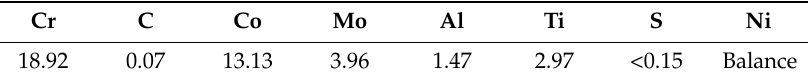
Table 1. Chemical composition of the GH4738 superalloy